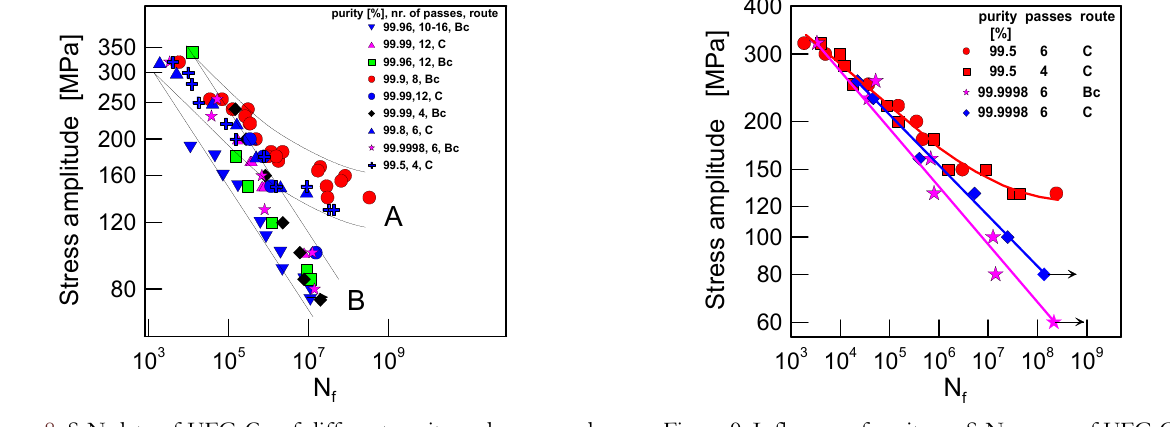
Figure 9: Influence of purity on S-N curves of UFG